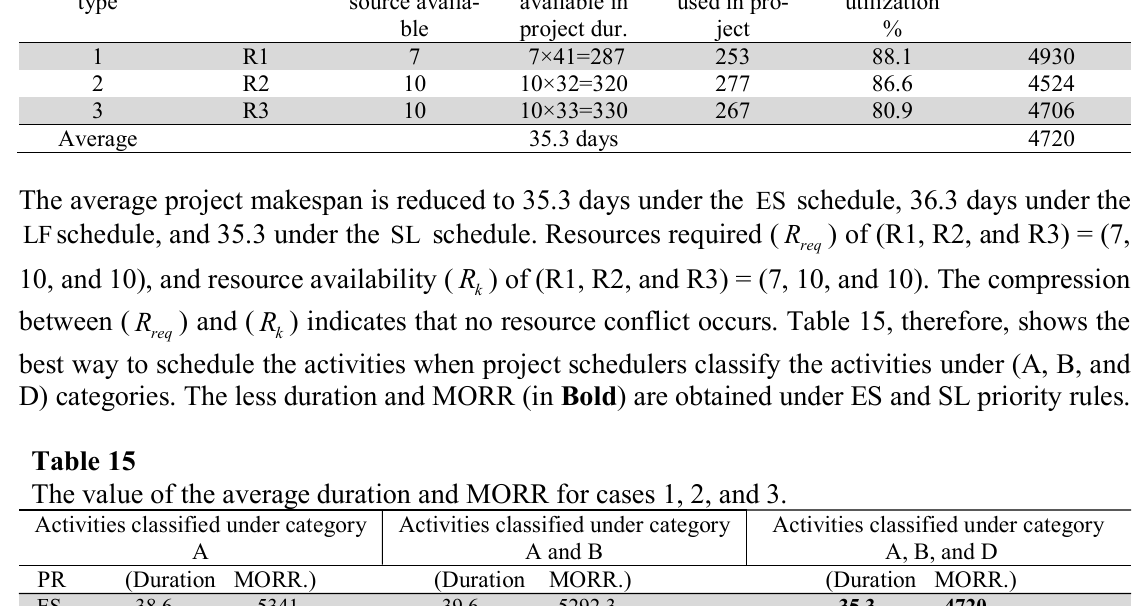
The value of the objective function obtained under SL priority rule for case 3 Project activities are classified under category A, B, and D (SL schedule) Resource